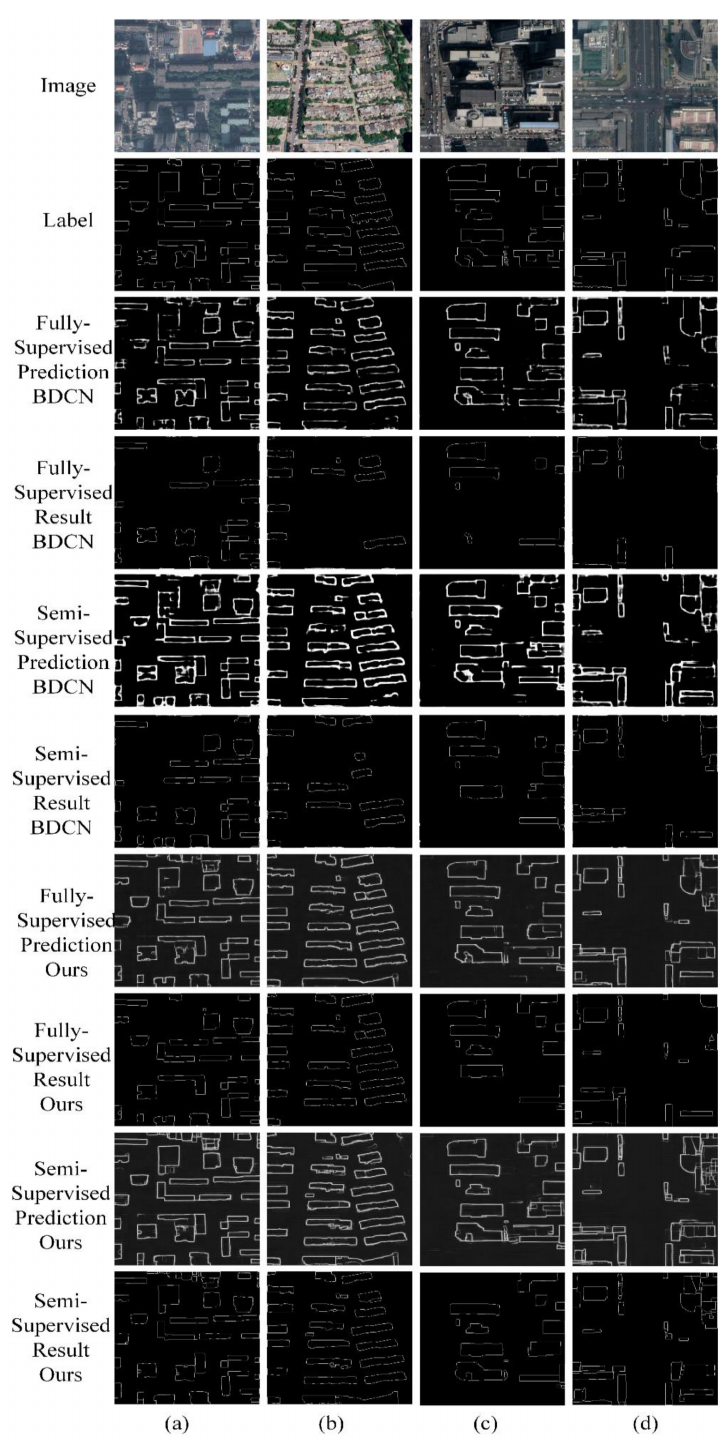
Figure 7. ( a – d ) are the results for fully supervised and semi-supervised building extraction in training distinctions. There are two edge detection models, BDCN and our model. The semi-supervised method uses the 50% labeled dataset and 100% unlabeled dataset, while the fully supervised method uses the 100% labeled dataset and 0% unlabeled dataset. The image is the original image taken in Beijing from Google Earth. The label is the ground truth of the image. Prediction is the edge strength map, which is the result of our network. The fully supervised and semi-supervised results are the complete edges, which, after post-processing, include binarization and thin, incomplete boundary